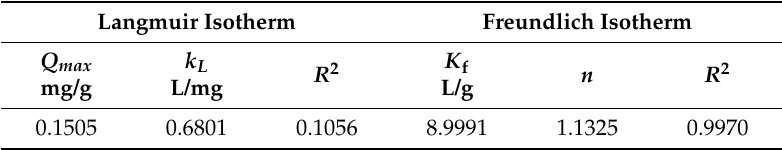
Figure 6. Langmuir ( A ) and Freundlich ( B ) adsorption isotherm for the adsorption of Zn 2+ onto PIL ‐ 3. Table 4. Adsorption isotherm parameters of Zn 2+ on PIL ‐ 3.